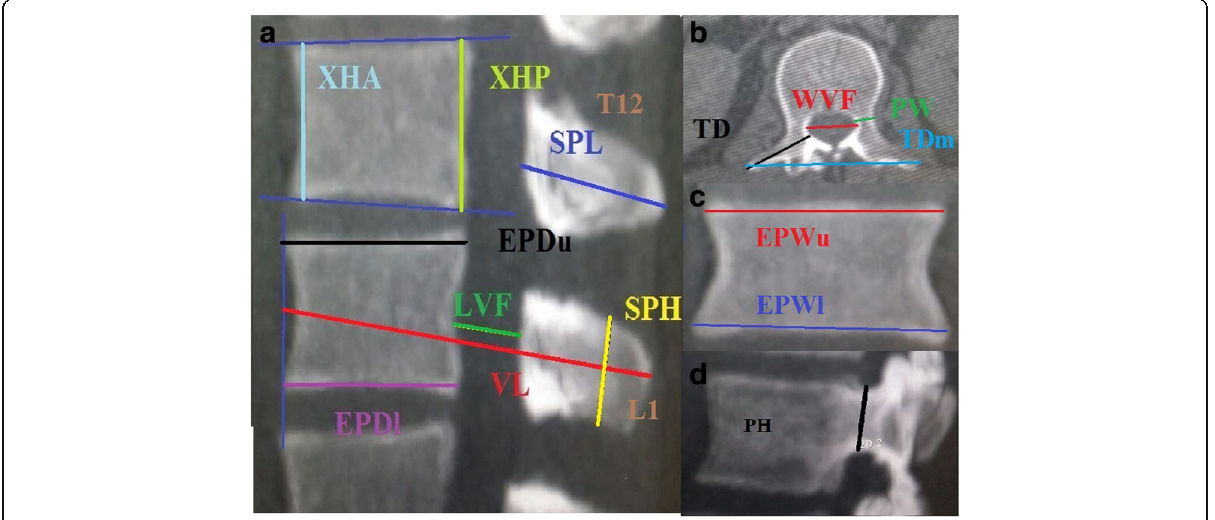
Fig. 1 Measurements taken from the first lumbar vertebra. a for sagittal images, b for axial images, c for sagittal images at pedicle level while d for coronal images. In ( a ) image measurements are demonstrated on T12 and L1 due to large number of